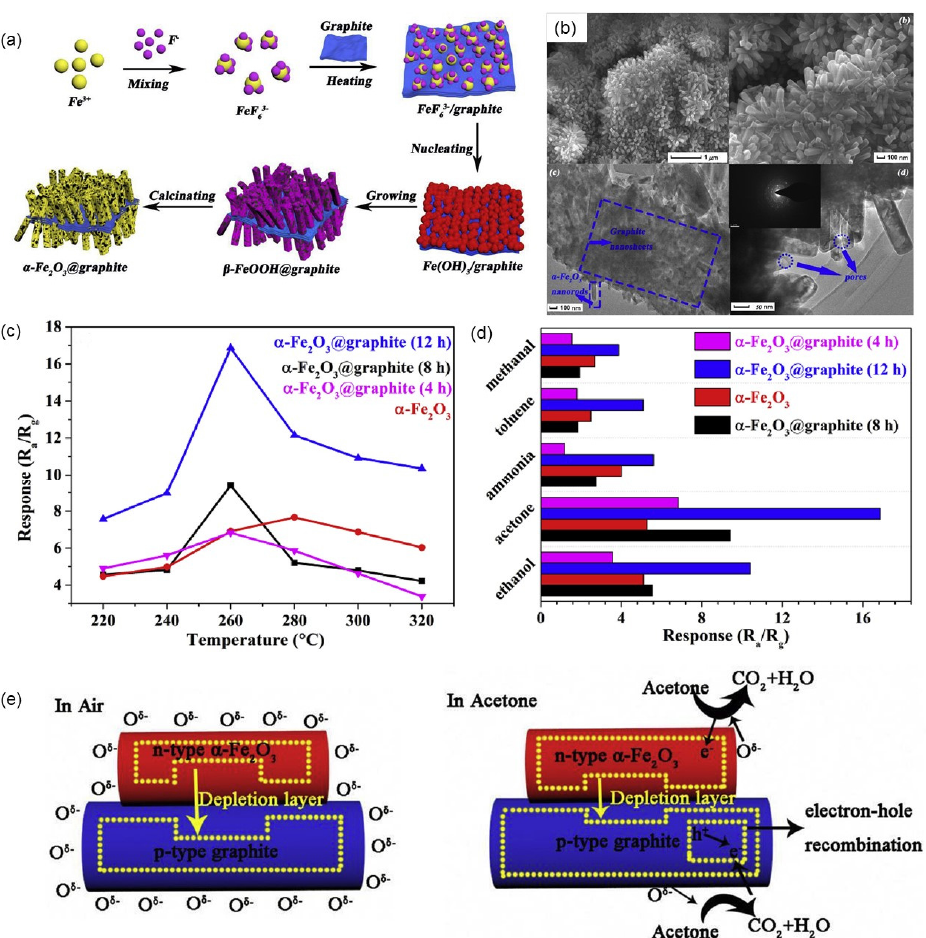
Figure 12. ( a ) Synthetic diagram of α -Fe 2 O 3 @graphite nanocomposites. ( b ) FE-SEM and TEM images of α -Fe 2 O 3 @graphite. ( c ) The responses to 50 ppm acetone of sensor based on α -Fe 2 O 3 and α - Fe 2 O 3 @graphite (with different reaction times) operated at different operating temperatures. ( d ) The response of α -Fe 2 O 3 and α -Fe 2 O 3 @graphite (with different reaction times) sensors to 50 ppm of different gases at 260 °C. ( e ) Reaction mechanism diagram of α -Fe 2 O 3 @graphite based gas sensor (O δ− means O − , O 2 − and O 2 − ). Reprinted with permission from Ref. [187]. Copyright 2019 Elsevier.